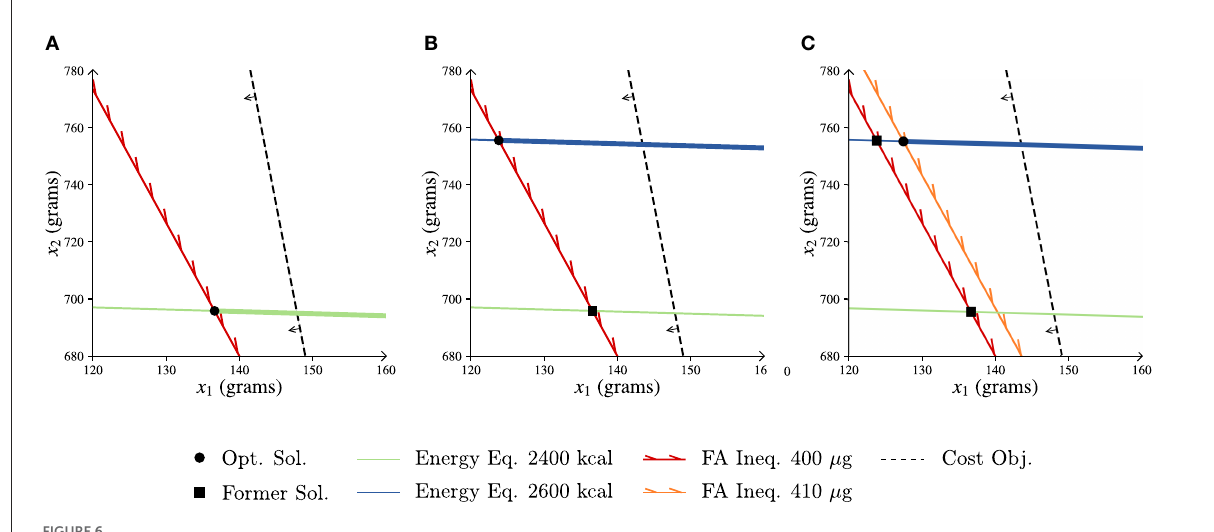
FIGURE6 LP representations of the more-for-less paradox example. Opt. Sol. is optimal solution, former sol. is former solution, eq. is equality, ineq. is inequality, obj. is objective and FA folic acid. (A) Start situation. (B) Increased energy requirement. (C) Increased energy and FA